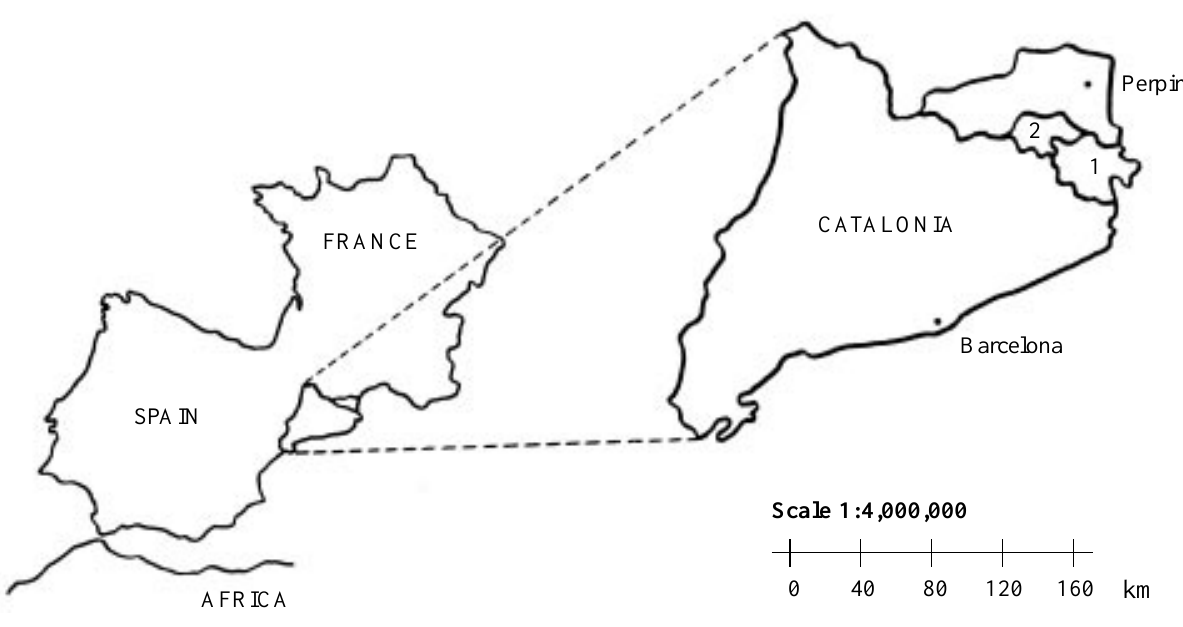
Figure 1 - Geographical location of the “Alberes” breed: 1, Alt Empordà region (Spain); 2, Vallespir region